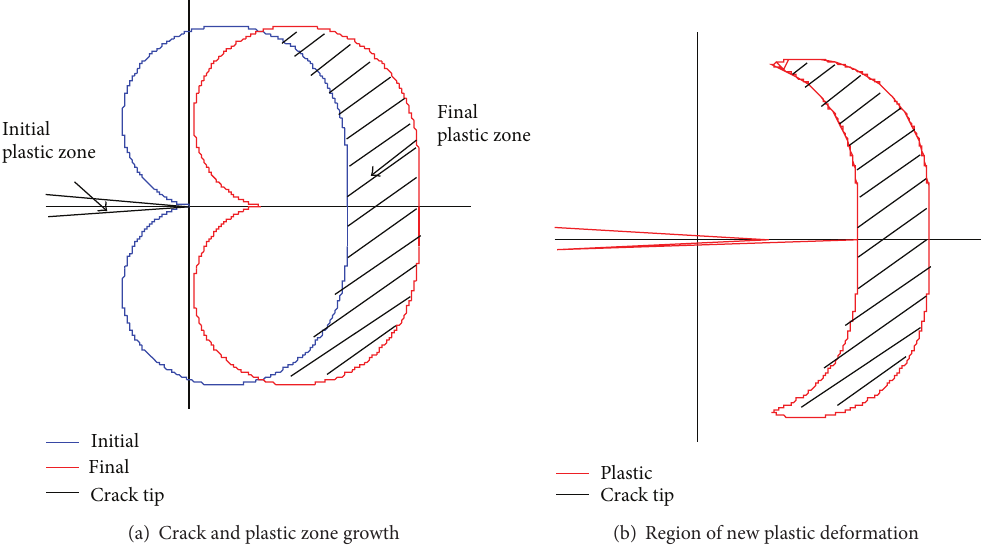
Figure 2: Crack tip and plastic zone for a thin plate.